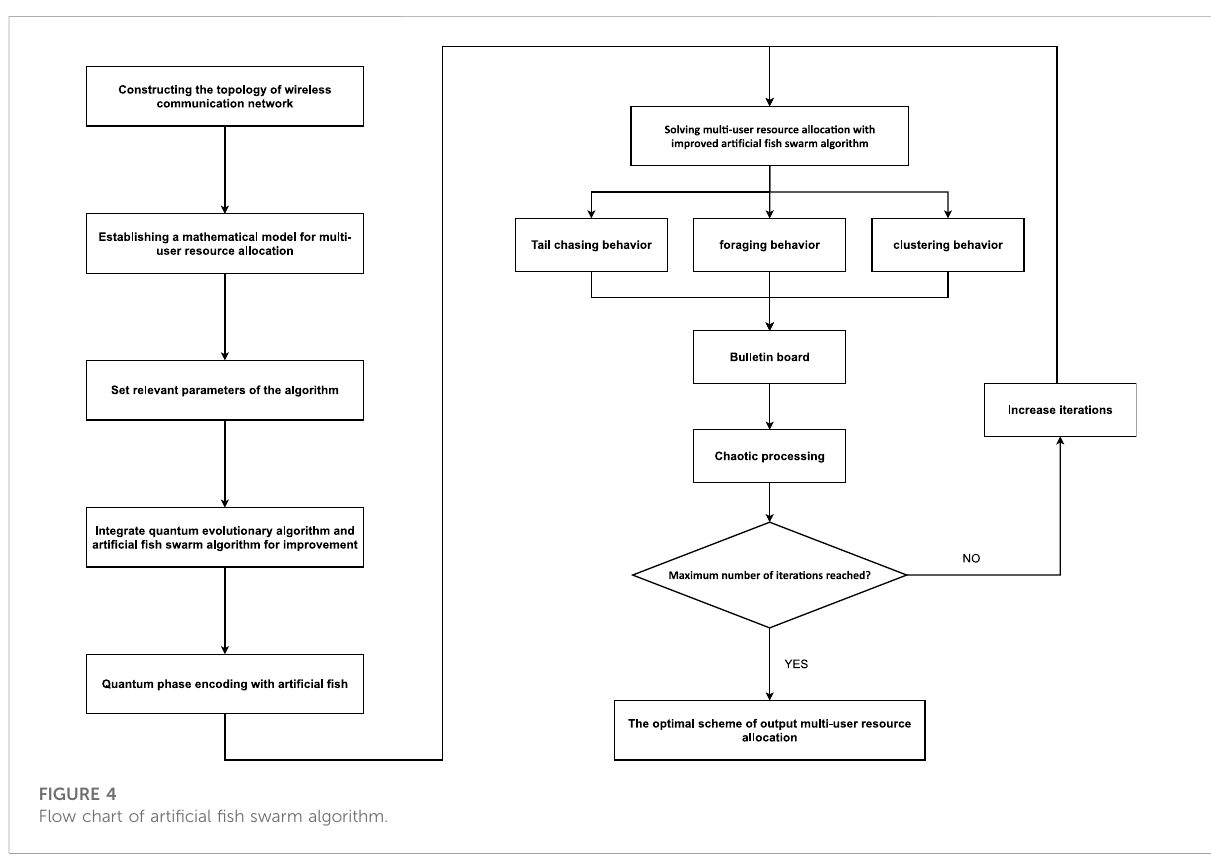
FIGURE 4 Flow chart of arti fi cial fi sh swarm algorithm.